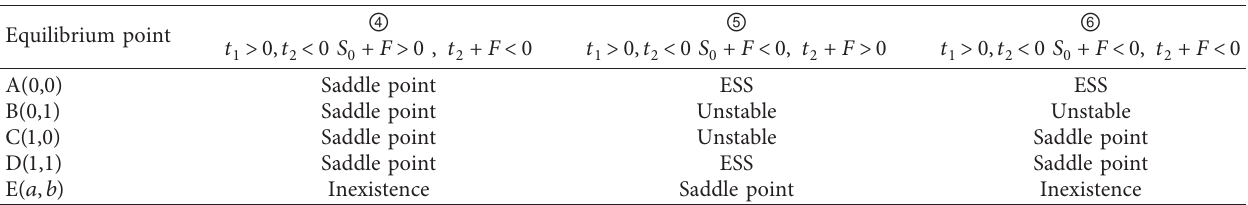
Table 8: Local stability of each equilibrium point in the range of different parameter values.